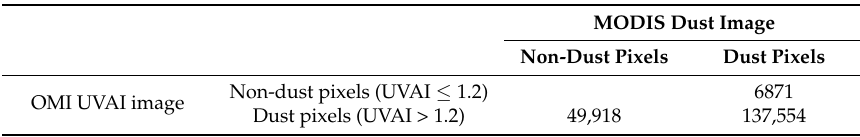
Table 6. The error analysis in the comparisons between MODIS dust image and OMI UVAI images with different UVAI